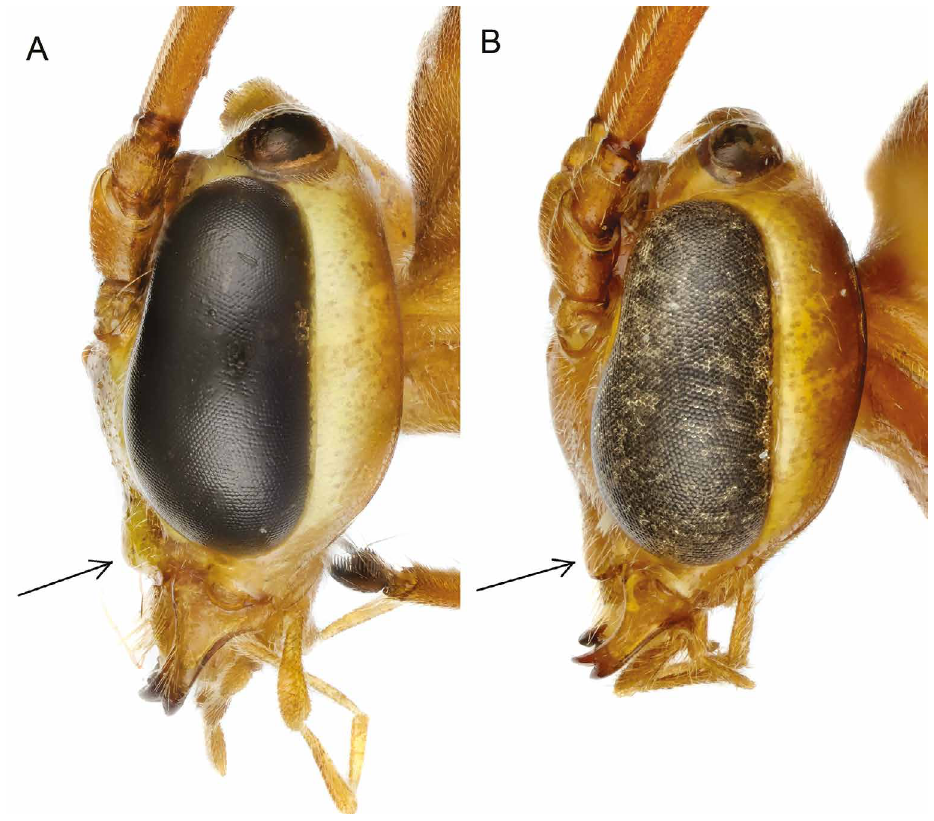
Fig. 14. Head in lateral view. A . Enicospilus merdarius (Gravenhorst, 1829), ♀. B . Enicospilus repentinus (Holmgren, 1860),